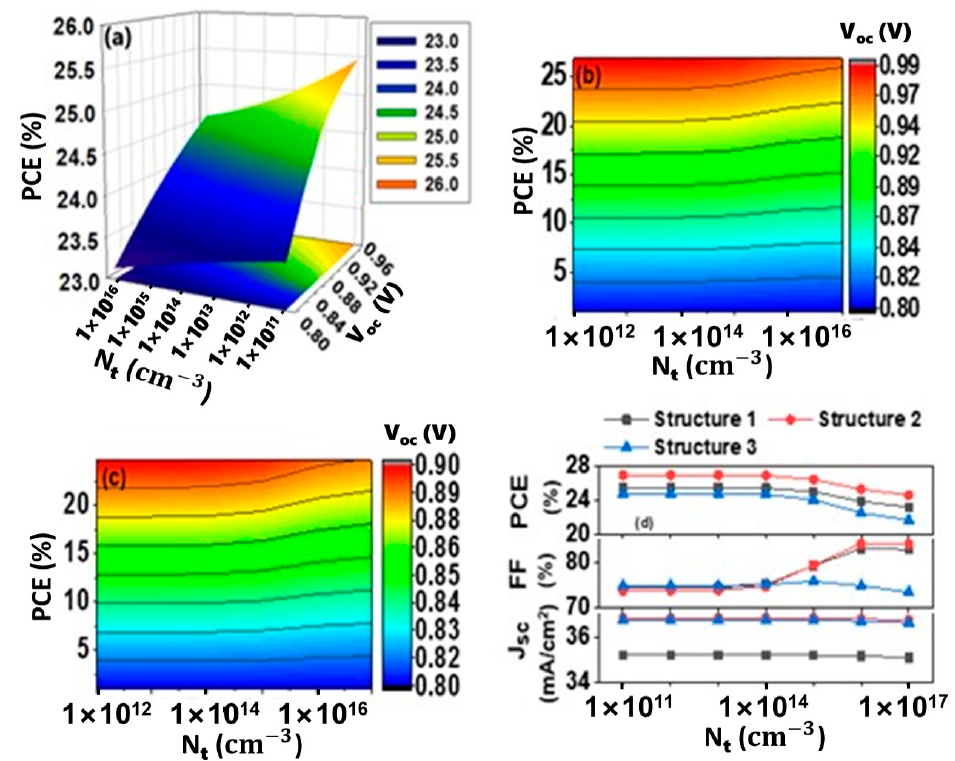
Figure 5. Effect of interfacial defect concentration (N t ) at IL2 interface; PCE and V oc vs. interfacial defect concentration for ( a ) Structure 1, ( b ) Structure 2 and ( c ) Structure 3, ( d ) J sc , FF and efficiency vs. interfacial defect concentration in IL2.